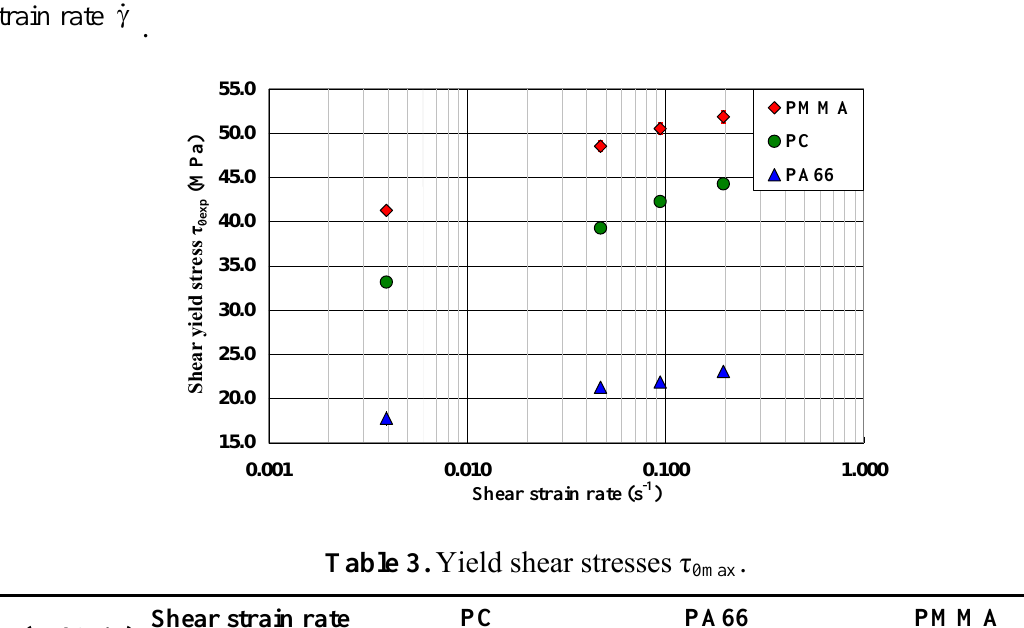
of PA66, PC, and PMMA as a function of shear 0exp